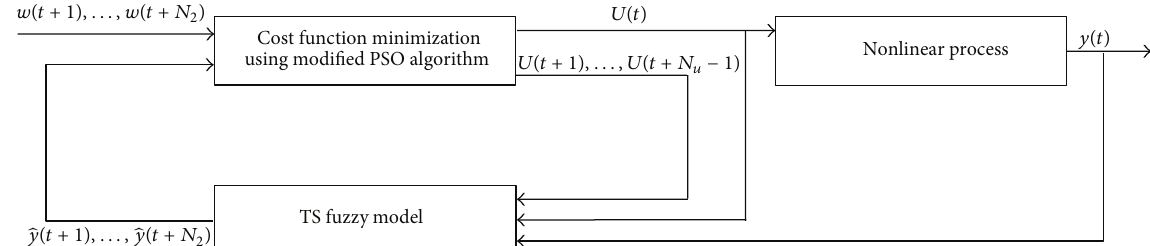
Figure 2: Block diagram of the proposed NMPC